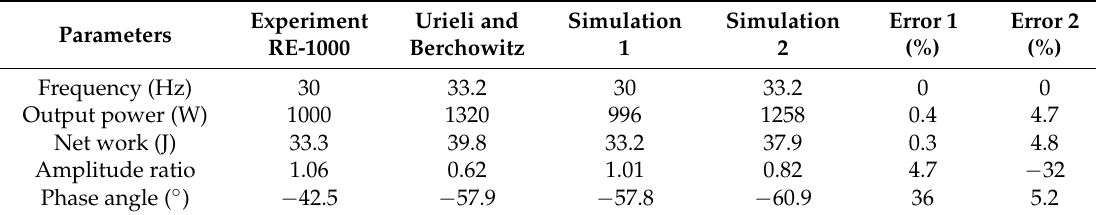
Table 5. Results from the validation of the numerical model of the free piston Stirling engine with the experimental output of the RE-1000